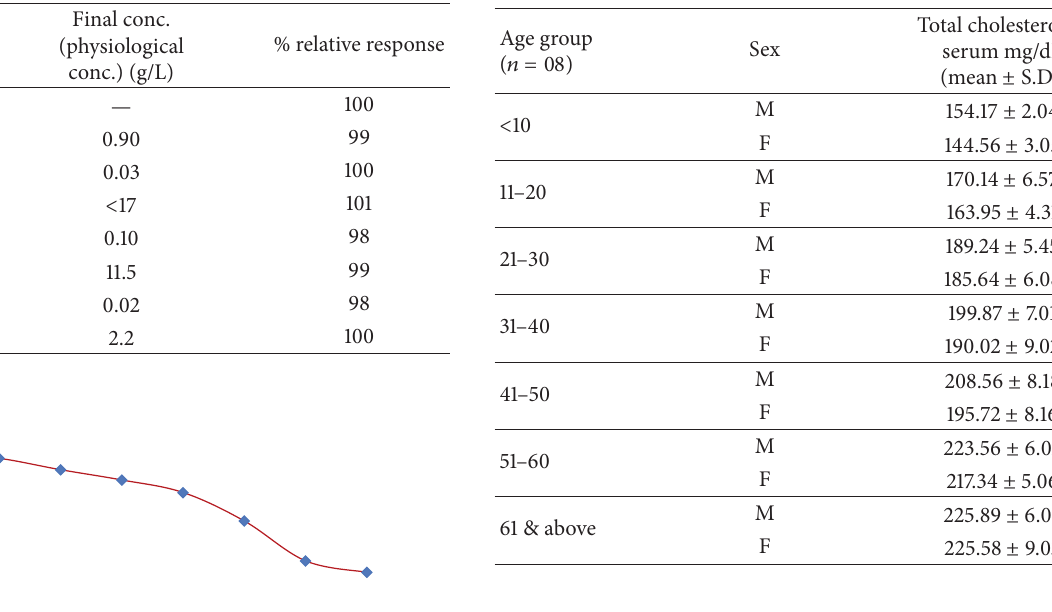
Table 5: Working parameters of the newly developed method.